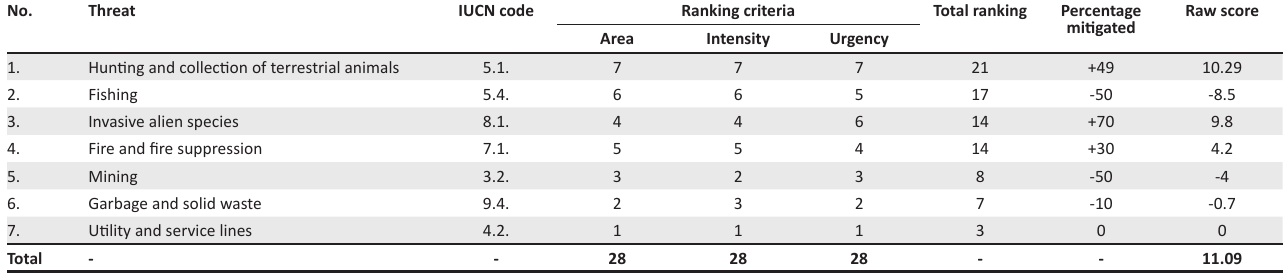
TABLE 2-A1: Threat reduction assessment index for Mahlangeni section of the Kruger National Park. No.